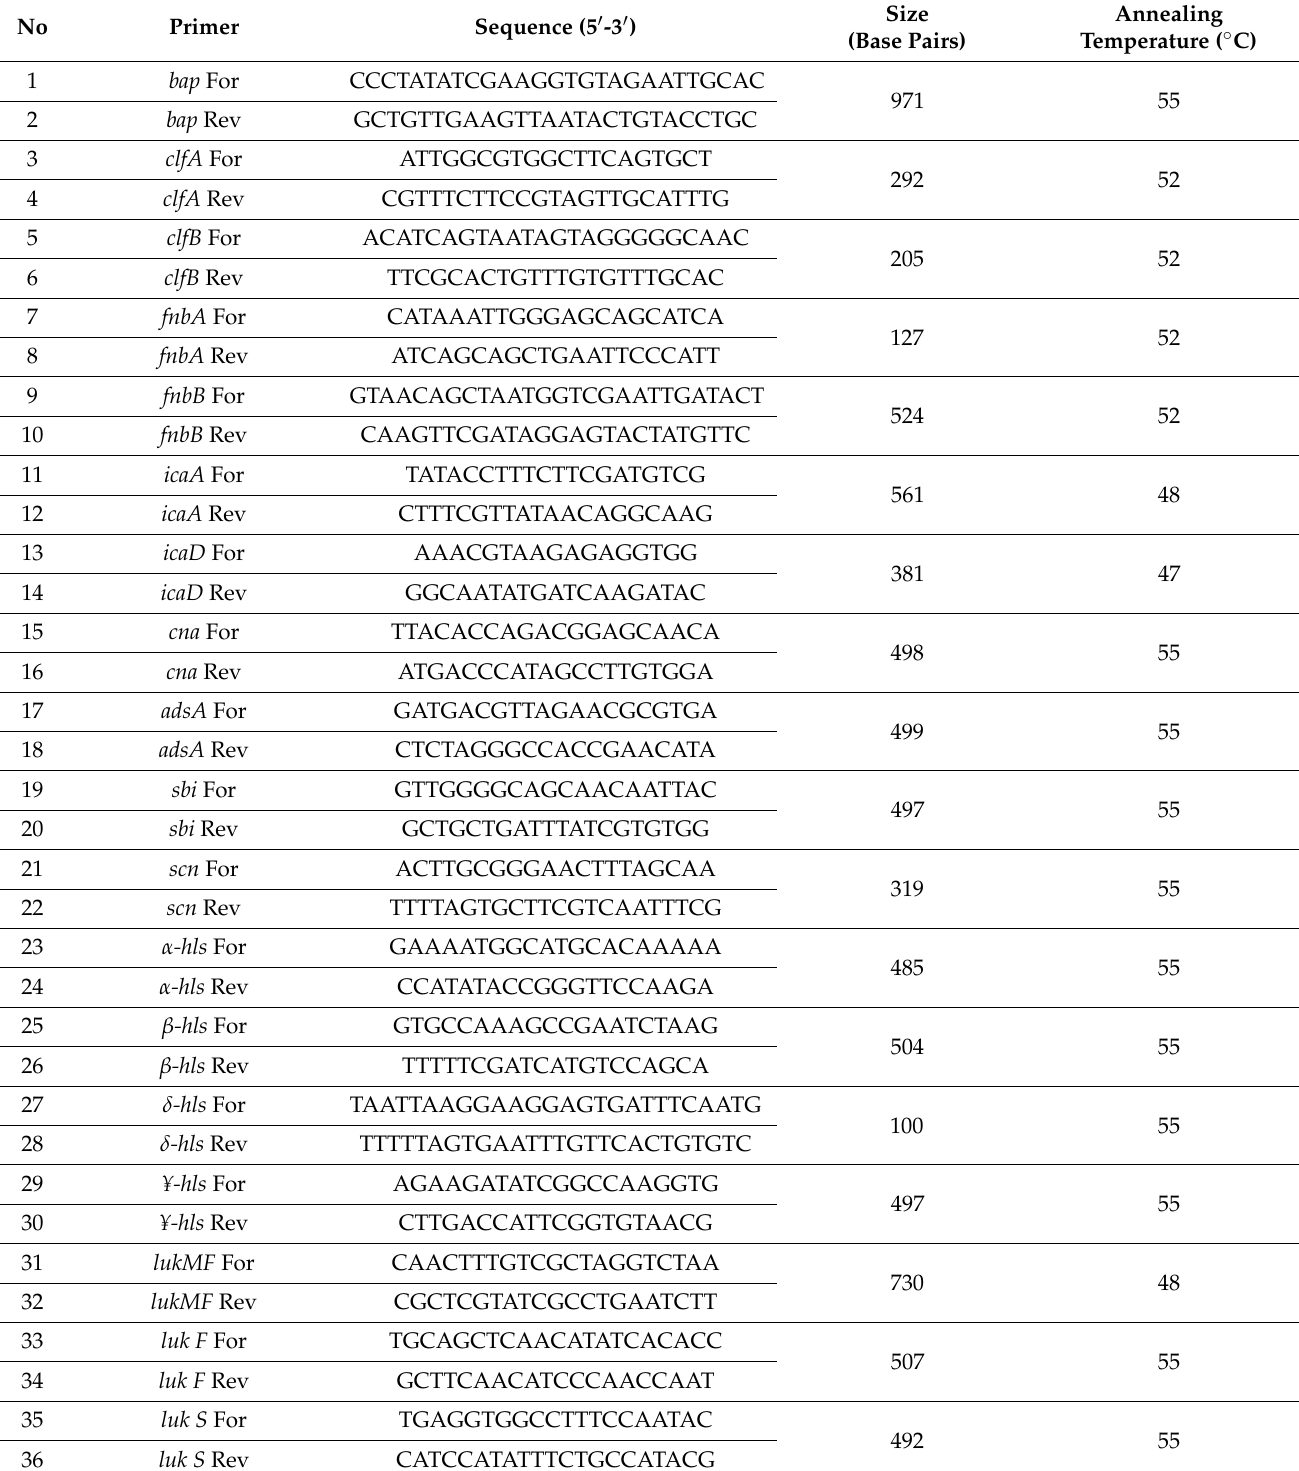
Table 1. List of primers used in the